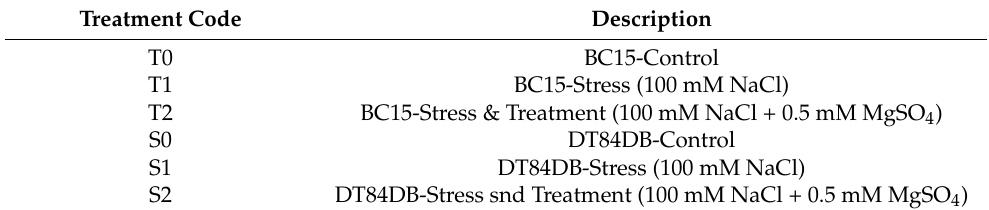
Table 3. List of samples and treatments.